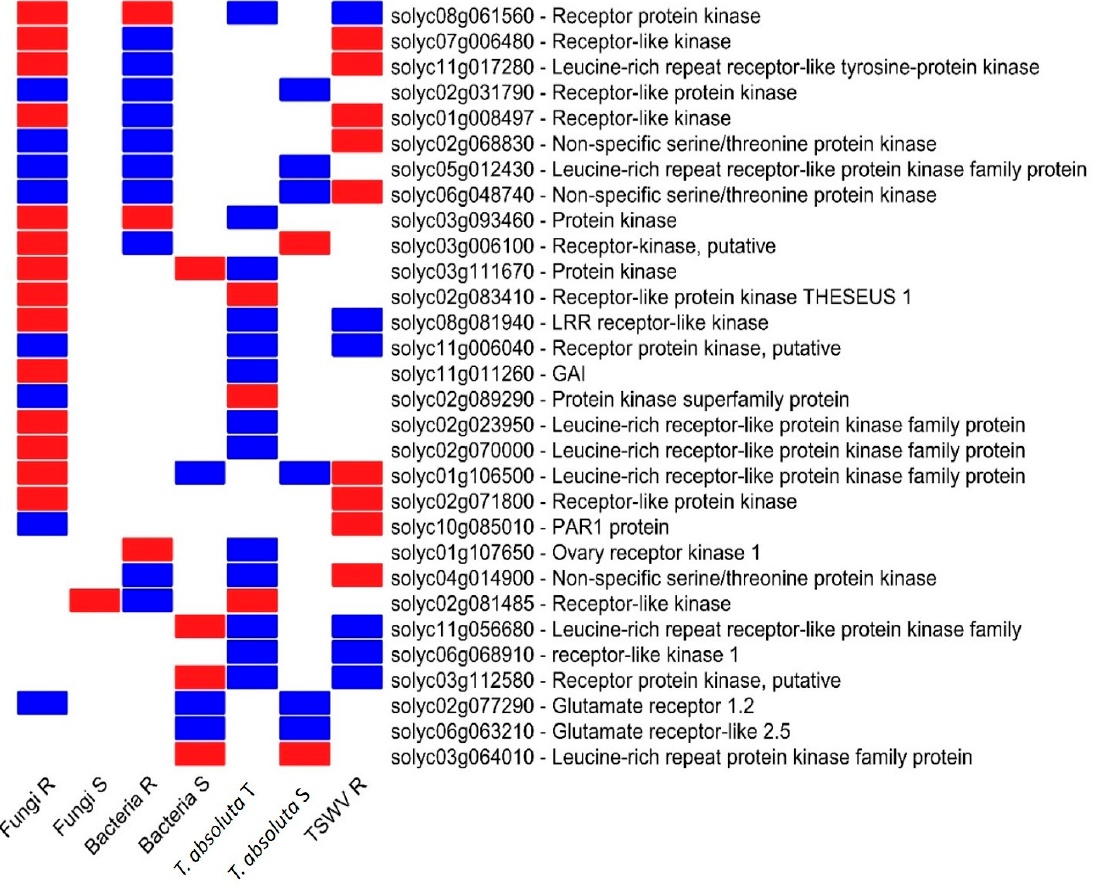
Figure 5. Heat map of DEGs participants in the signaling process. The expression pattern of DEGs identified and their function have been reported. Blue = upregulated, and red = downregulated genes. R = resistant; S = susceptible; T = tolerant genotype.